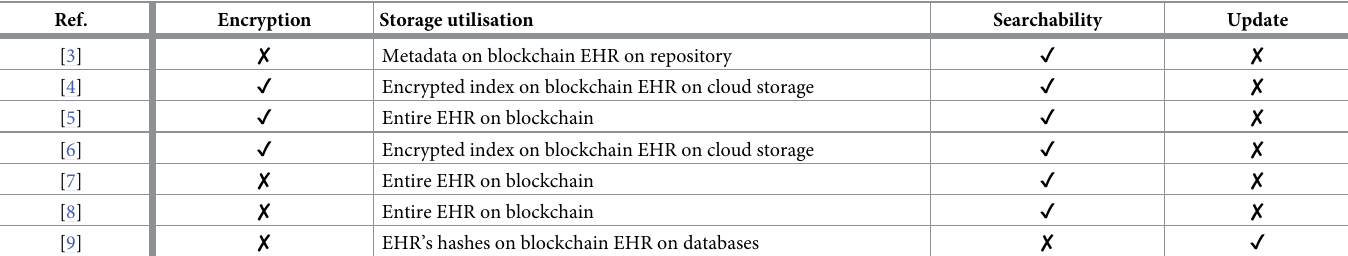
Table 1. Multiuser SSE—Key features comparison ( ✔ : Supported; ✘ : Not supported).